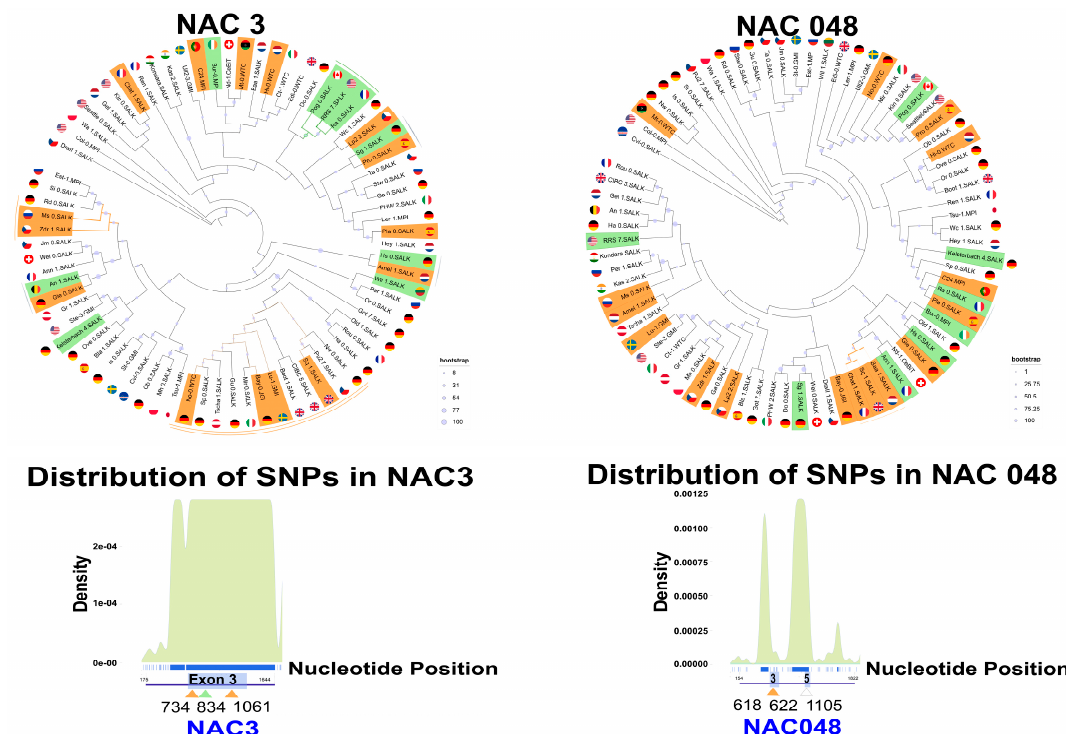
Figure 5. Phylogenetic trees of NAC3 and NAC048 and SNPs distribution derived from the alignment of homologs from 79 accessions. ( A ) NAC3 and NAC048 phylogenetic trees. Accessions with small PR are colored in orange; accessions with large PR are green. External green line: a clade with accessions with large PR; External orange line: a clade with small PR; External orange double line: a clade with deletion in the 3 (cid:48) of NAC3 ; External gray line: clades that comprise accessions with contrasting character states (small, large). ( B ) Distribution of SNPs density across NAC3 and NAC048 . Bottom blue line: consensus gene sequence. Blue boxes: Exon regions. Orange triangles: SNPs associated with small PR clades. Green triangles: SNPs associated with large PR clades. White triangle: SNPs not associated with a large or small PR